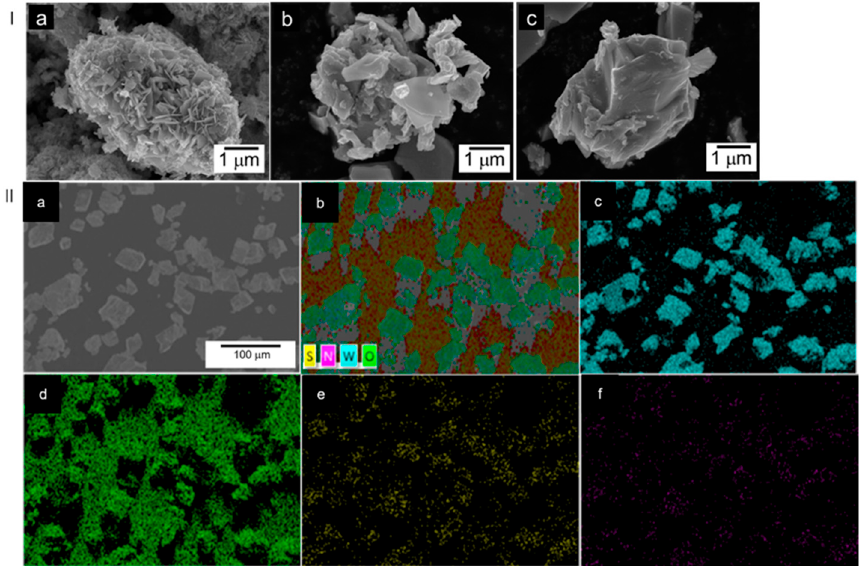
Figure 2. ( I ). SEM images of ( a ) WO 3 − 0, ( b ) WO 3 − 5, and ( c ) WO 3 − 15 samples, respectively; ( II ) ( a ) SEM_EDX elements distribution mapping images of the WO 3 − 15; ( b ) W, O, S, N layered, ( c ) W, ( d ) O, ( e ) S, and ( f ) N, respectively. Table 1. Summary of physicochemical properties of various WO 3 samples.